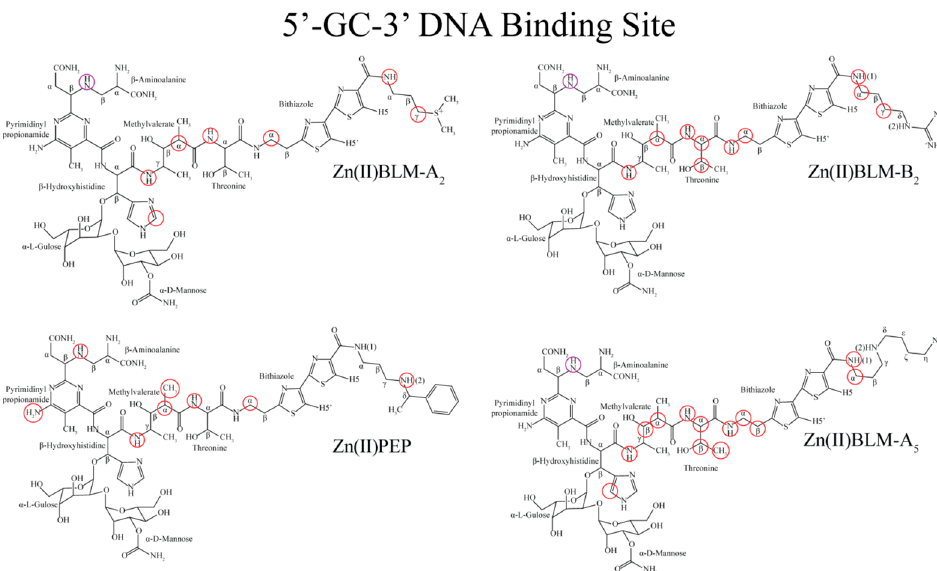
Figure 2. Protons exhibiting significant shifts in their OL 1 -bound forms. (red circles) and protons that could not be assigned in the bound forms (purple circles) for spectra acquired in H 2 O at 5 °C.